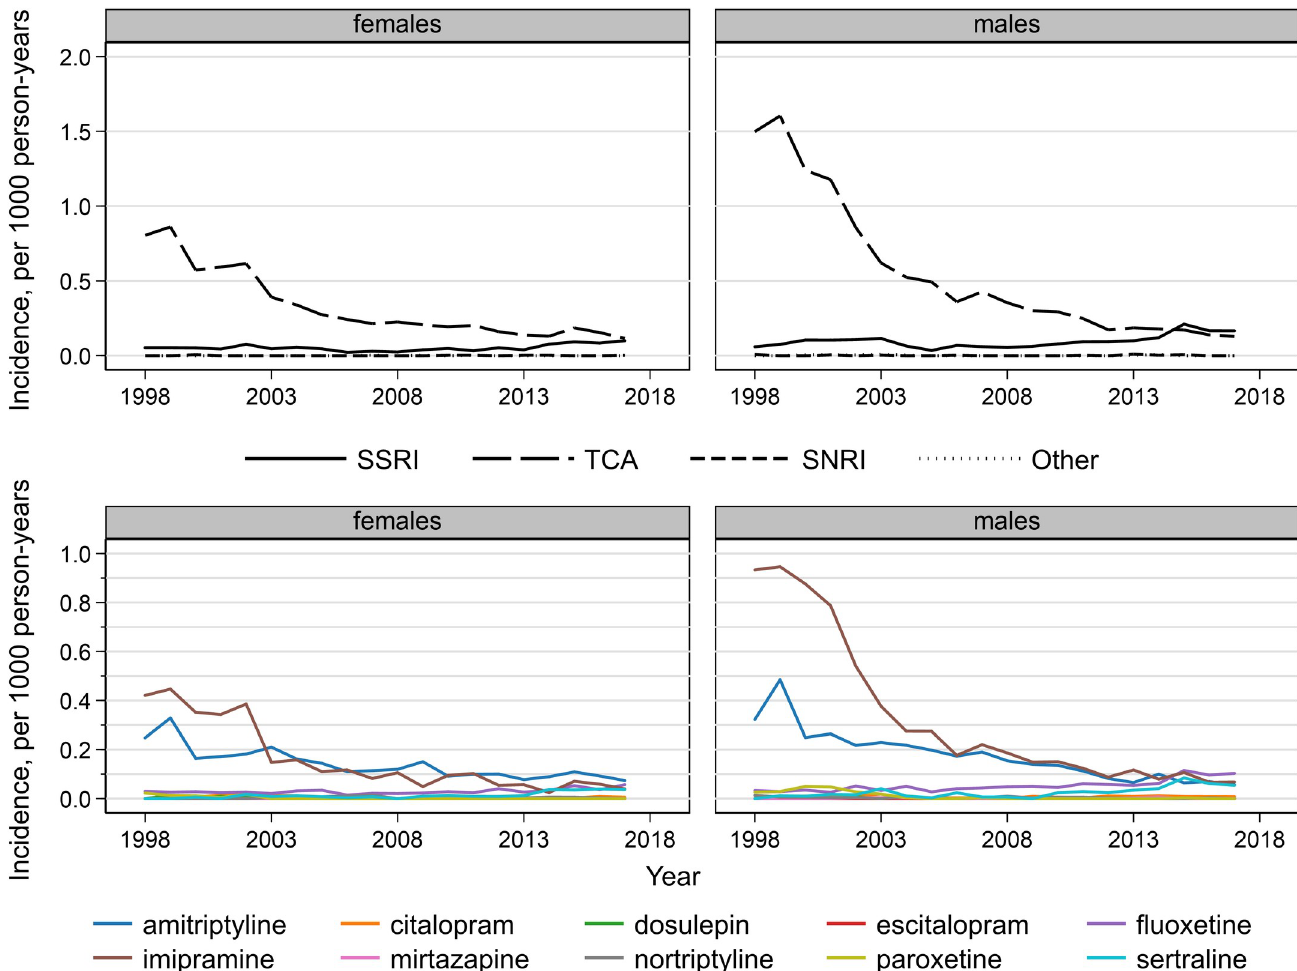
Fig 2. Antidepressant drug class and individual drug incidence rates per 1,000 person-years in 5- to 11-year-olds, England, 1998–2017, by sex. SNRI, serotonin and norepinephrine reuptake inhibitor; SSRI, selective serotonin reuptake inhibitor; TCA, tricyclic and related antidepressant